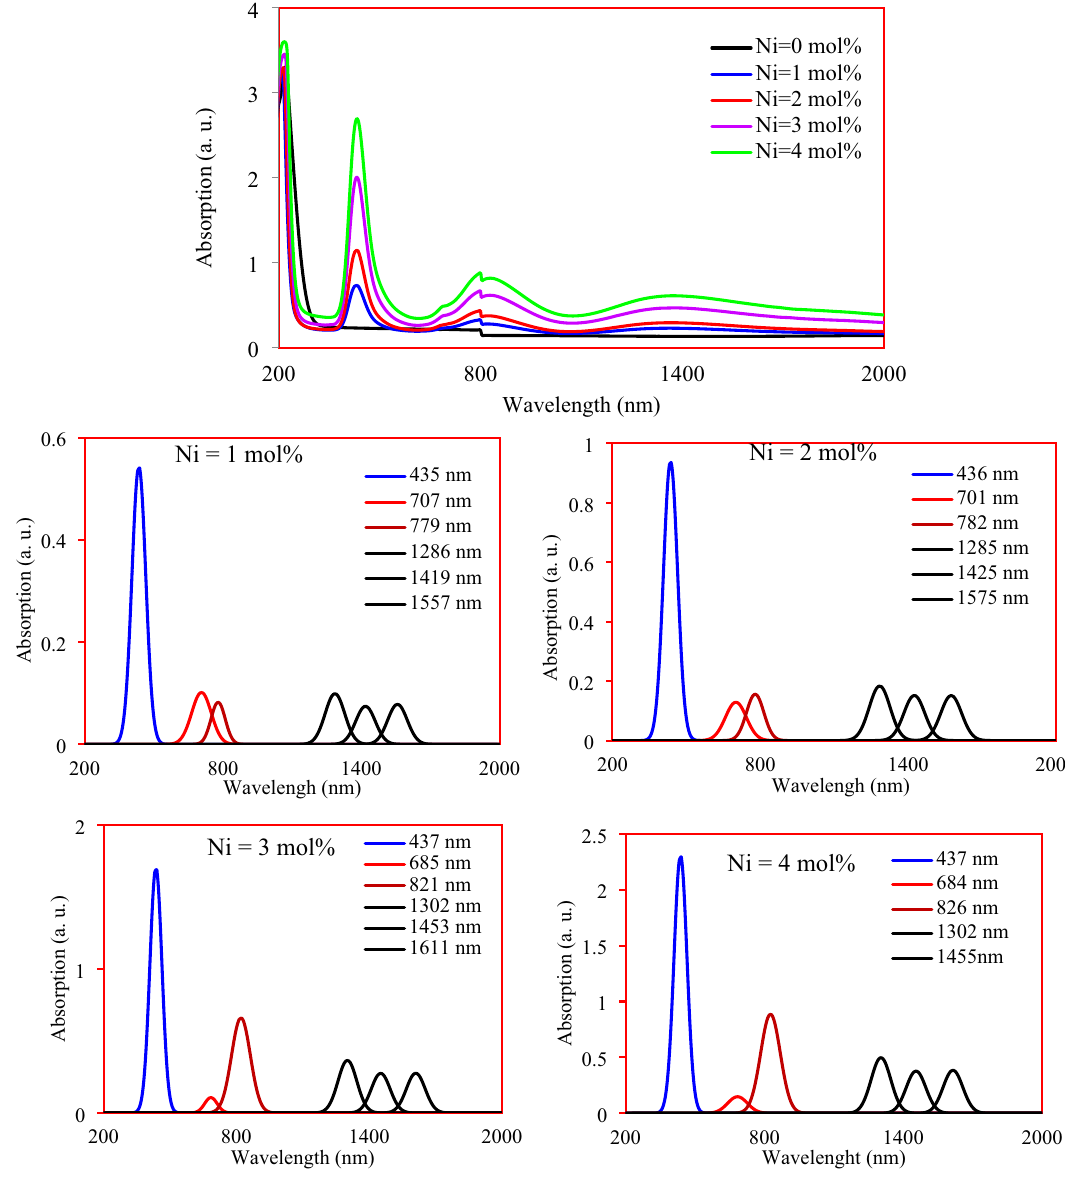
Figure 10. Optical absorption spectra and the deconvolution of the studied